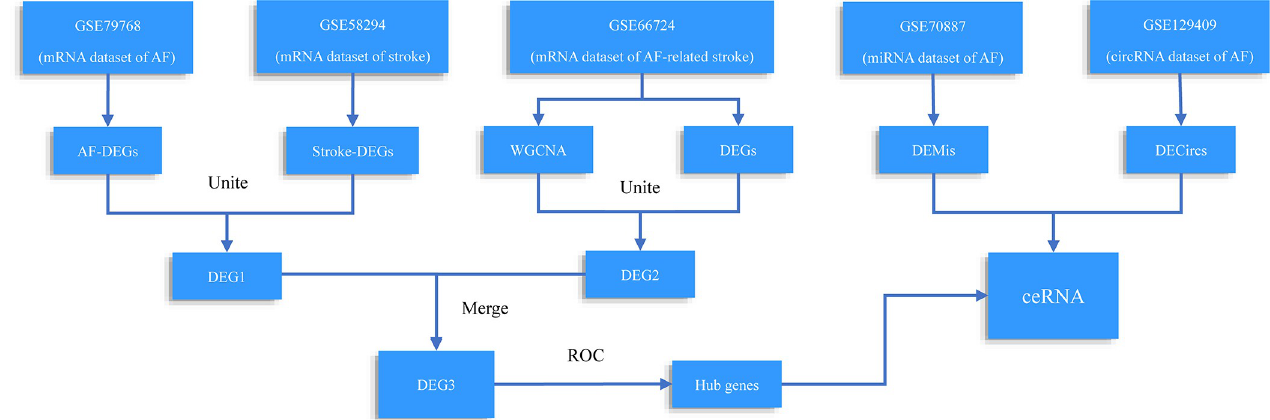
Fig 1. Flow chart of data preparation, processing, and analysis. GSE79768 (atrial fibrillation mRNA dataset), GSE58294 (stroke mRNA dataset), GSE66724 (atrial fibrillation related stroke mRNA dataset), GSE70887 (atrial fibrillation miRNA dataset), GSE129409 (atrial fibrillation circRNA dataset). DEMis (differently expressed miRNAs), DECircs (differently expressed circRNAs), ceRNA (competitive endogenous RNA).